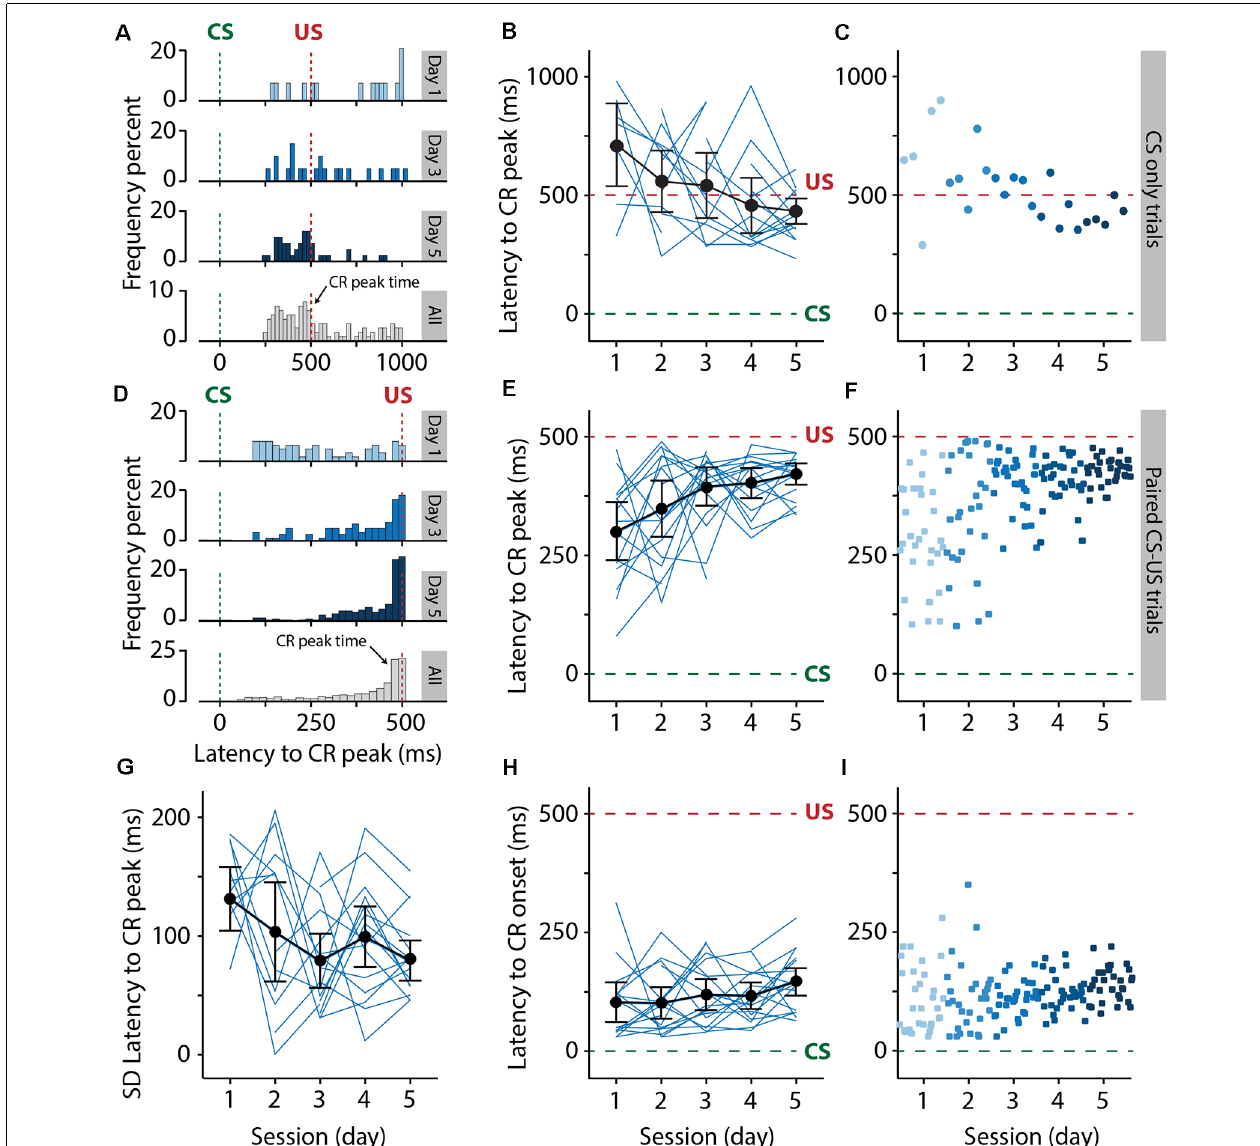
FIGURE 6 | Pigs learn the eyeblink conditioning task, as shown by the adaptive timing of the conditioned eyelid responses. (A–C) Development of the distribution of the latency to CR peak from day 1 to day 5 in CS only trials. (D–F) Similar to (A–C) but now for paired CS-US trials. The green dashed line indicates CS onset and the red dashed line indicates US onset. (A–C) Histograms showing the distribution of latency to CR peak for day 1, 3, 5, and all days combined. (B–E) Individual pig learning curves (thin light blue lines) and group-averaged learning curve (thick black line) as a function of session. Error bars indicate the 95% confidence interval. (C–F) Trial-by-trial values whereby each dot represents the average of all animals for all values for that trial. The colors (ranging from light blue to dark blue) correspond with the colors of the averaged eyeblink traces in panel (A) . Green dashed line indicates CS onset, red dashed line indicates US onset. The latency to CR peak time lacked a temporal preference in the first session, but clearly showed preference from the moment that animals started to show CR more reliably in session 2 and onwards. Note how the CR peaks concentrate around the onset of the US. A statistically significant effect of session was found for the latency to CR peak. (G) Standard deviation of the latency to CR peak as a function of session. Thin light blue lines represent individual pig curves and the thick black line is the group-averaged curve. Error bars indicate the 95% confidence interval. A statistically significant effect of session was found for the SD of the latency to CR peak, indicating that the variability in the CR peak times get smaller over time. (H,I) The latency in milliseconds to the onset of eyelid CR in the interval between 150 and 500 ms after CS onset. The latency to CR onset remained stable over time. No statistically significant effect of session was found for the latency to CR onset. For